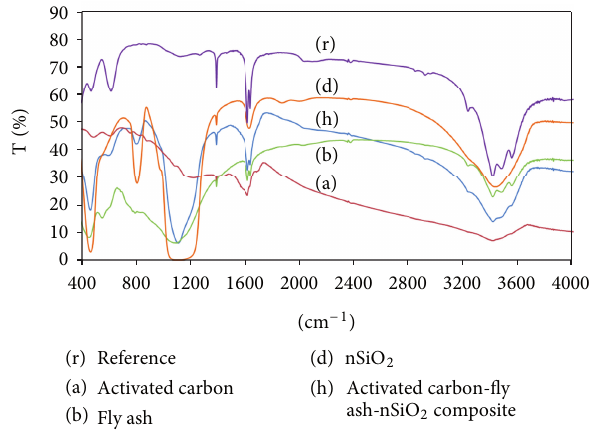
F 12: F�I� spectrum of precursors and activated carbon-�y composite material. ash-nSiO 2